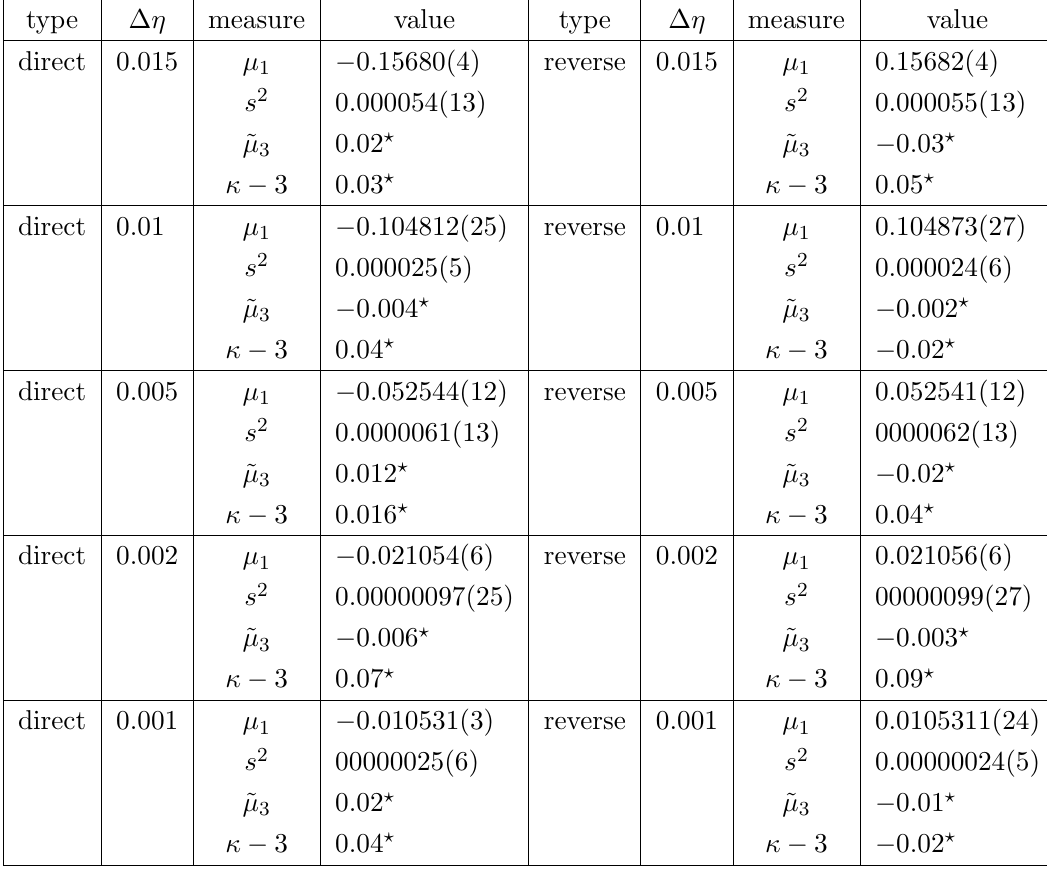
Table 17 . Moments of the Euclidean-action di(cid:11)erence (cid:1) S obtained in non-equilibrium simulations of SU(2) Yang-Mills theory at (cid:12)xed L=a = 5, (cid:12) = 2 : 7124 and n values of (cid:1) (cid:17) , in direct and in reverse non-equilibrium transformations. Values denoted by a star are compatible with zero within their